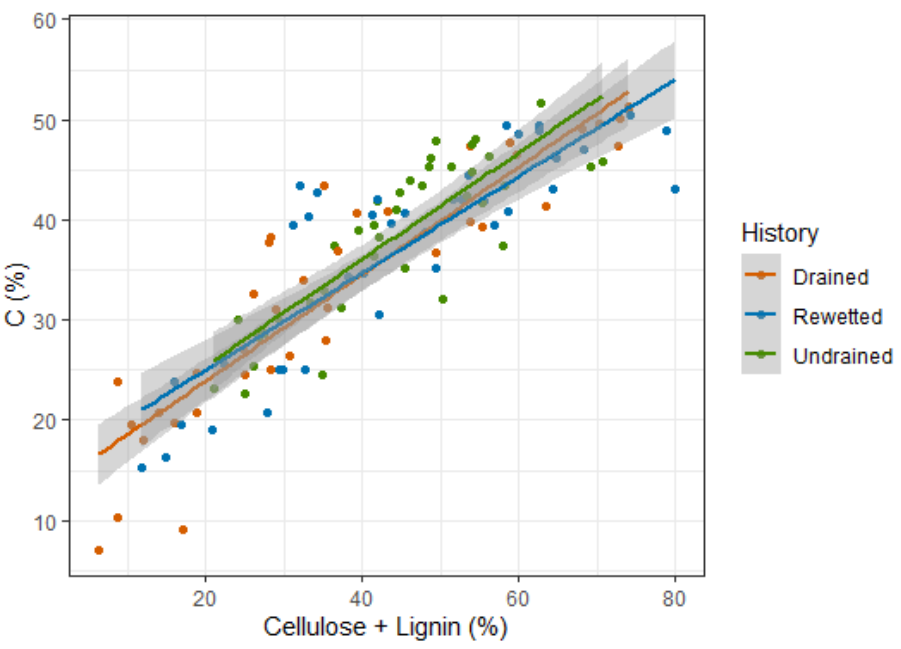
Figure A2. Positive relationship between the cumulative fractions of cellulose and lignin (% ADF-cellulose + % ADF-lignin) and total soil carbon (% C) contents as determined by standard C analysis through combustion on a CN-analyser (Pearson’s r = 0.88, P < 0.001). Analyses were part of a different study (Emsens et al . 2020), in which 117 fen peat samples were collected at 3 depths (from 0 to 50 cm below the surface) in 39 different fen sites (including the study sites of the current study) that differed in drainage history (drained, rewetted or